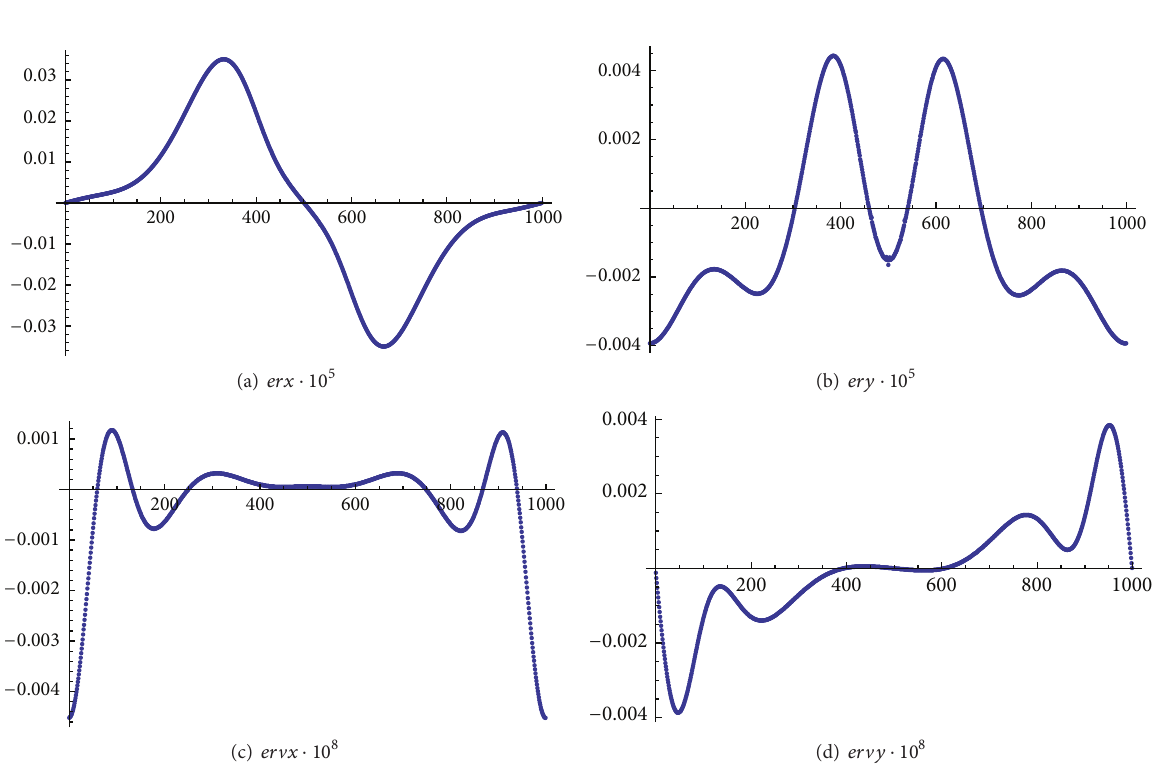
Figure 3: Local integration errors distribution 𝛼 = 1.5